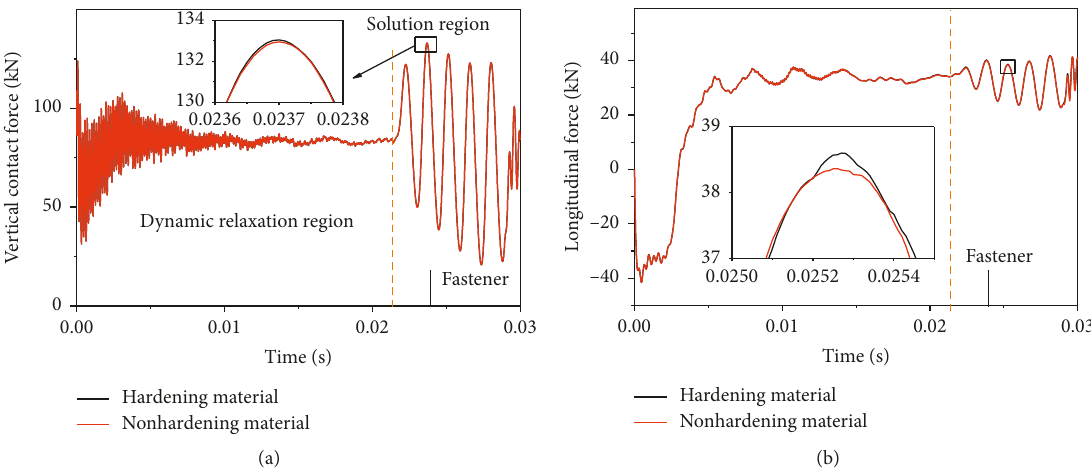
Figure 12: Time history curve of contact force: (a) vertical contact force; (b) longitudinal contact